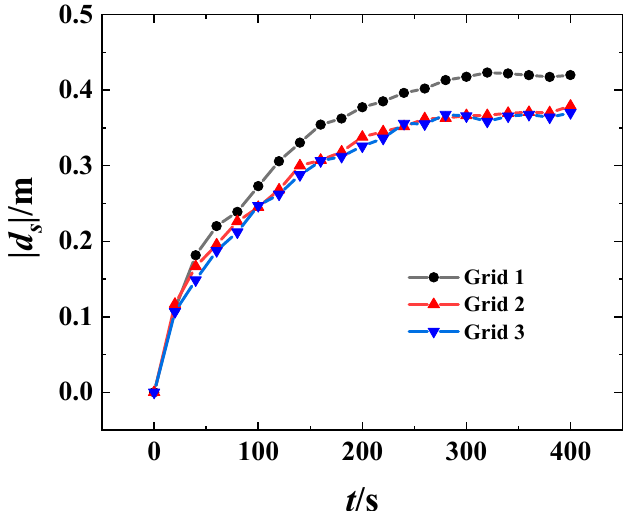
Figure 7. Time evolution of maximum scour depth around cylinder with different grid size (Case 2).